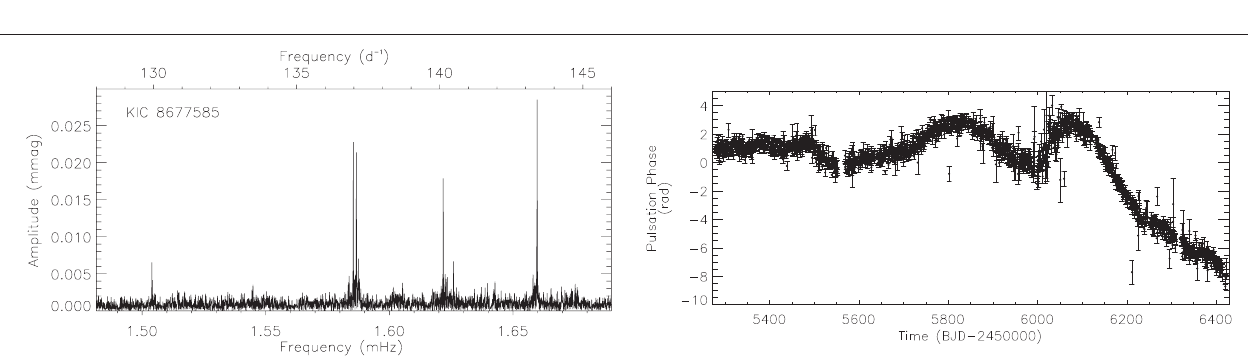
FIGURE 4 | (Left) The pulsations seen in KIC8677585 in the high-frequency range. (Right) The phase variation of the principal mode in the left panels. There is significant frequency variability present in this